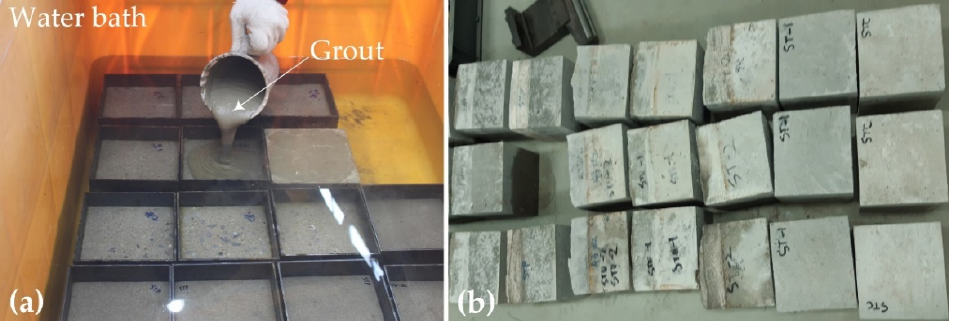
Figure 2. ( a ) Underwater grouting process in a water bath; ( b ) water-bath-cured test specimens.